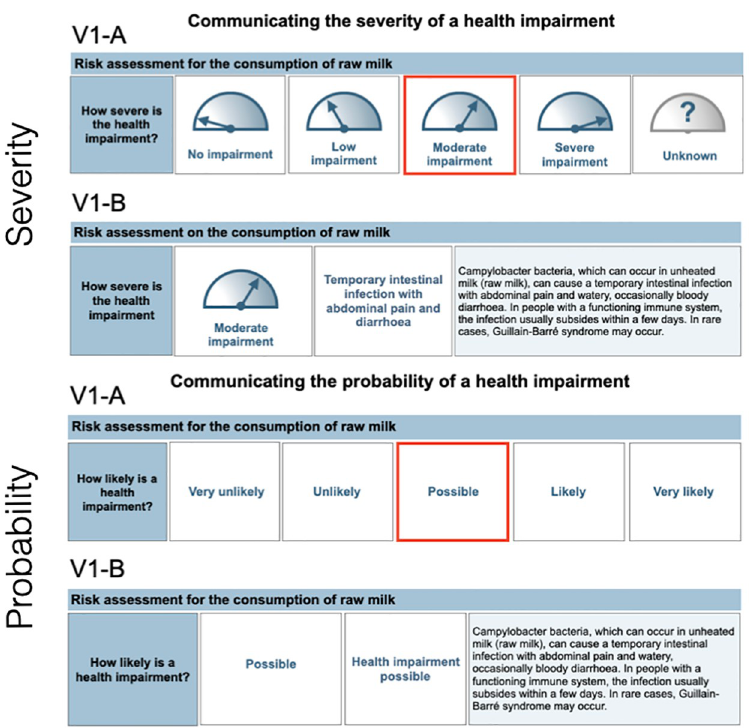
Fig 3. Prototype examples of V1-A and V1-B developed to communicate the severity and probability of outcomes dimensions.